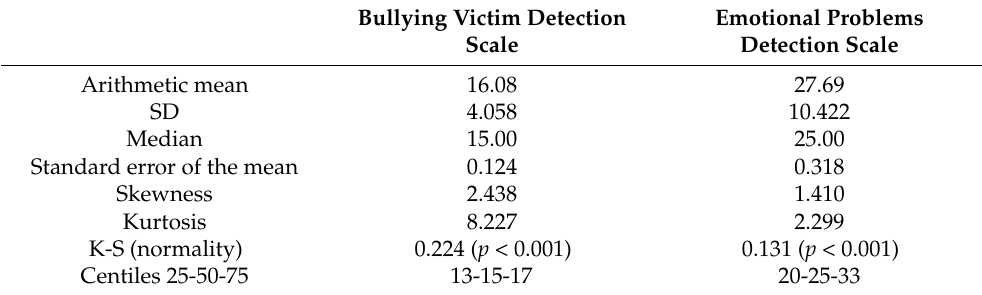
Table 9. Overall descriptive statistics for the bullying and emotional problems detection scales.